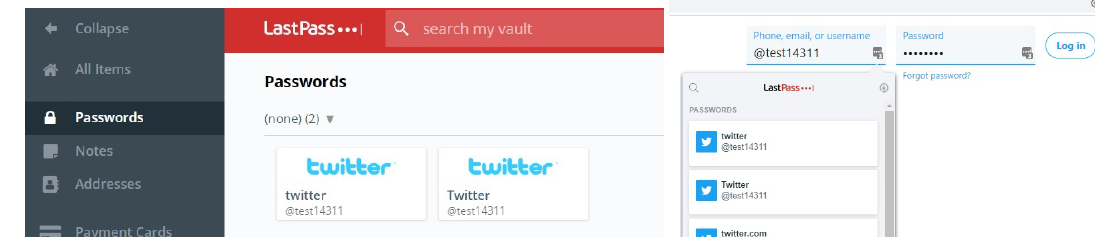
Figure A6. LastPass does not prevent users from storing different passwords for the same account “Twitter”. The account can appear twice on the autofill log-in “Twitter website”.